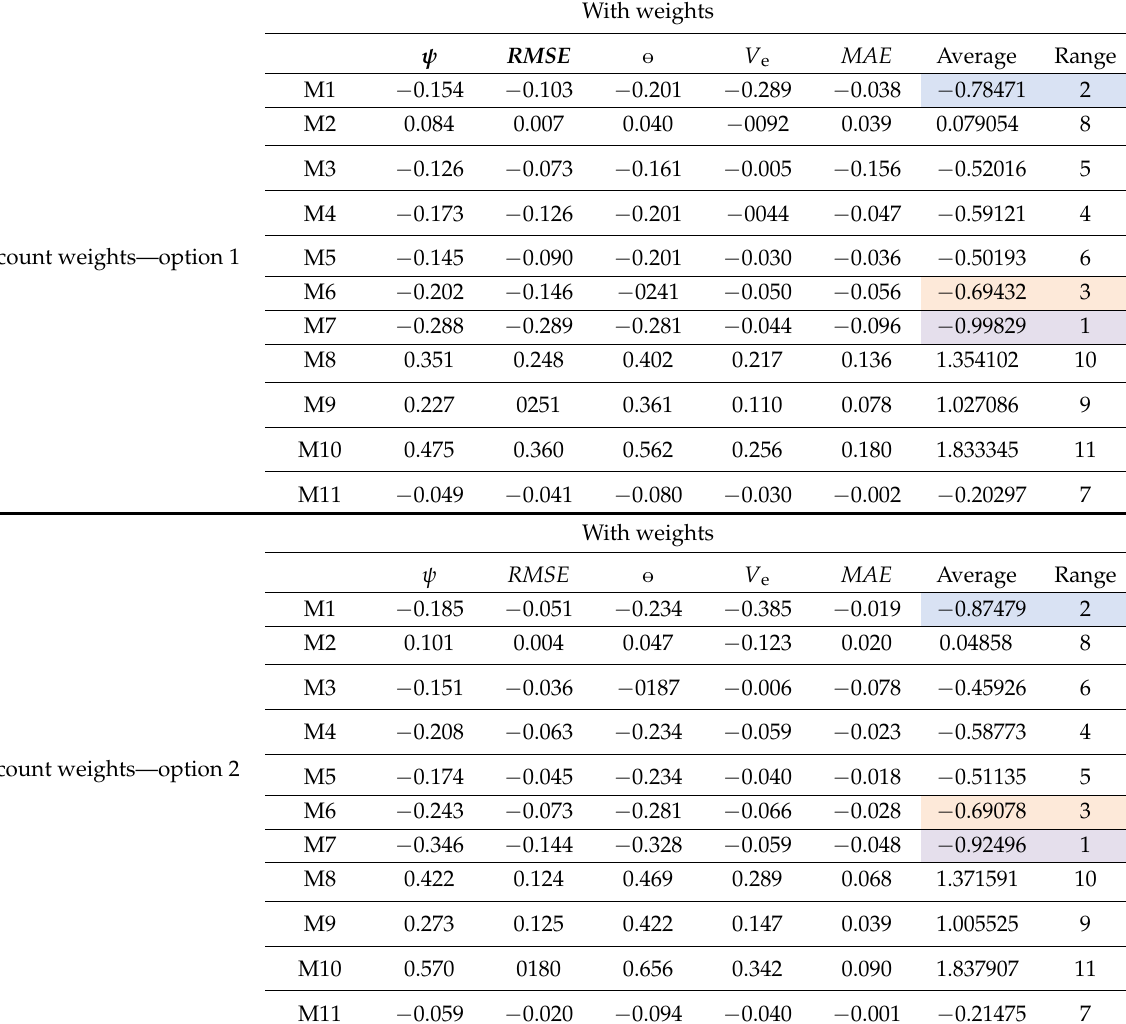
Table 7. Error assessment values with weights included—Option 1 and Option 2.